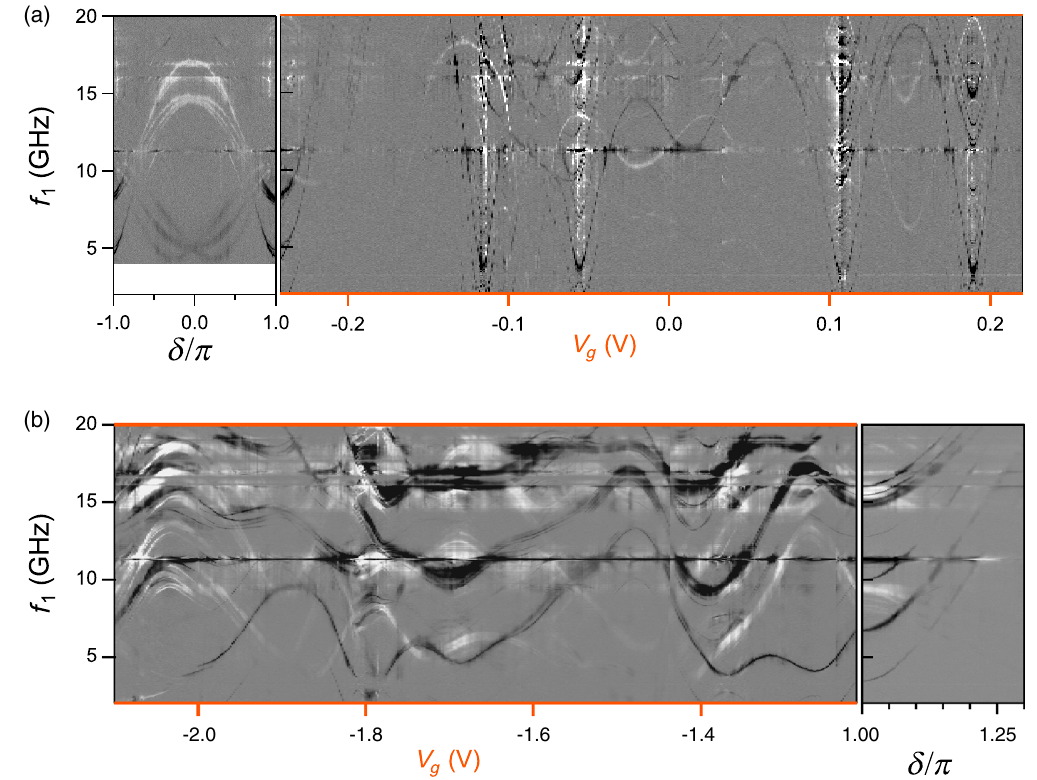
FIG. 10. Spectrum as a function of gate voltage at δ ¼ π [right of (a), left of (b)] for two intervals of gate voltage and taken during different cooldowns. (a) Left panel and (b) right panel: Phase dependence at the gate voltages corresponding to V ¼ − 1 . 21 V (b)], which correspond to the leftmost (resp. rightmost) gate voltages of the panels showing the V V g